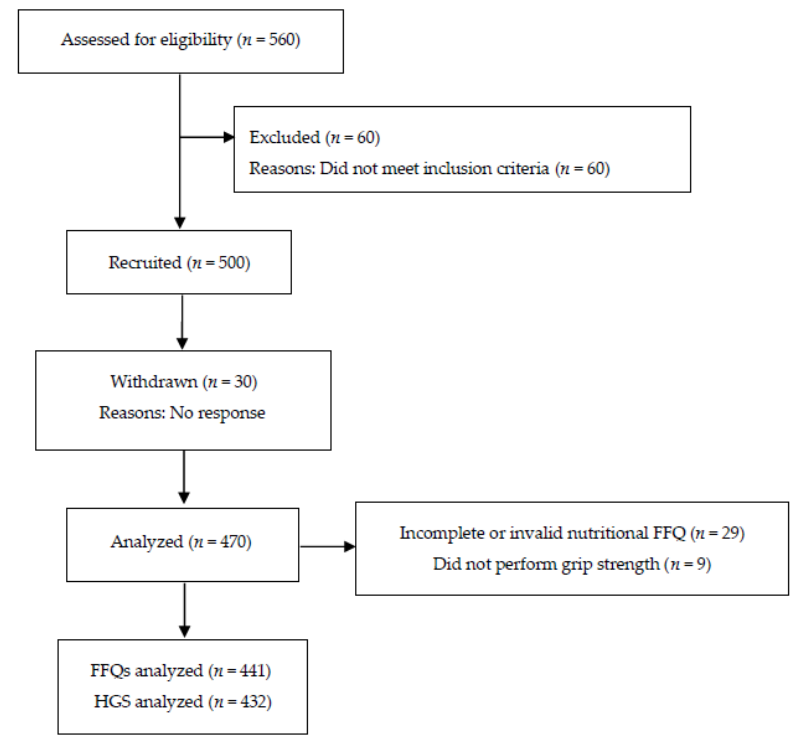
Figure 1. Flow chart of enrollment for the study. Table 1. General characteristics and nutrient intake of study participants 1.